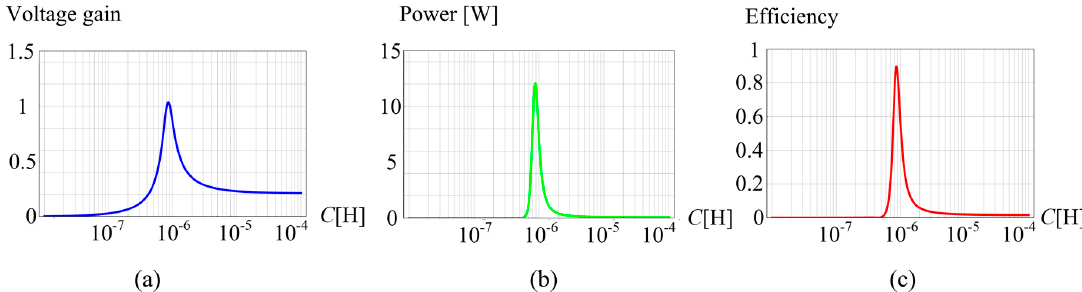
Figure 14. ( a ) Curve chart of voltage gain related to compensation capacitor; ( b ) Curve chart of power related to compensation capacitor; ( c ) Curve chart of efficiency to compensation capacitor. ( C : compensation capacitor).